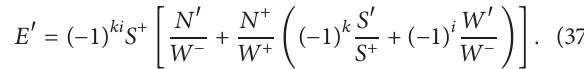
Paszkowski identity for 𝐶(𝑚/𝑛) , equivalent to the previous, gives also 𝐸 󸀠 or/and 𝑆 󸀠